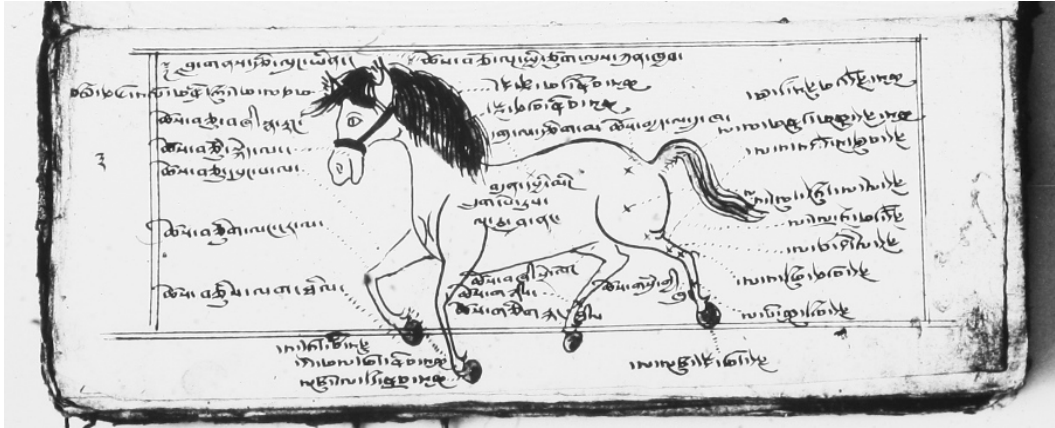
Figure 3. The position of the bla gnas in the manuscript from Tsum (Nepal).